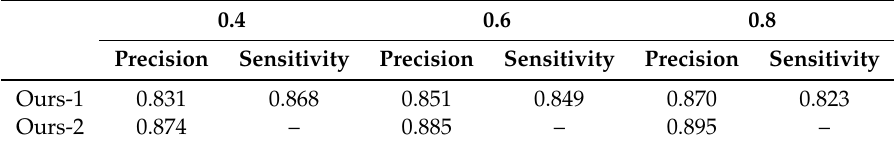
Table 6. Detection results with confidence